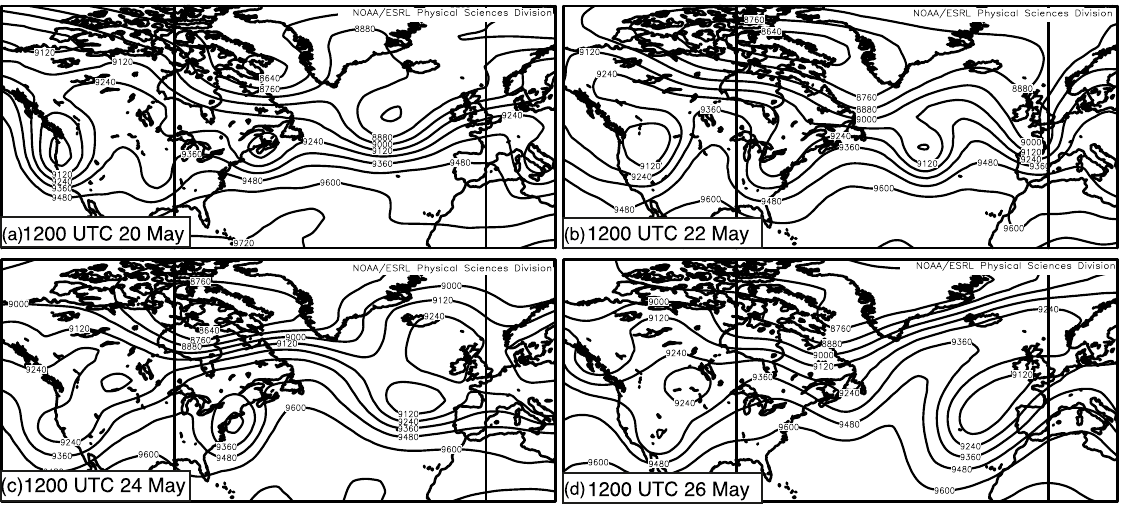
Figure 11. Geopotential height (m) at 300hPa for 20–26 May 2016 from NCEP–NCAR reanalyses (Kalnay et al., 1996), showing how the zonal flow developed into a blocking pattern.